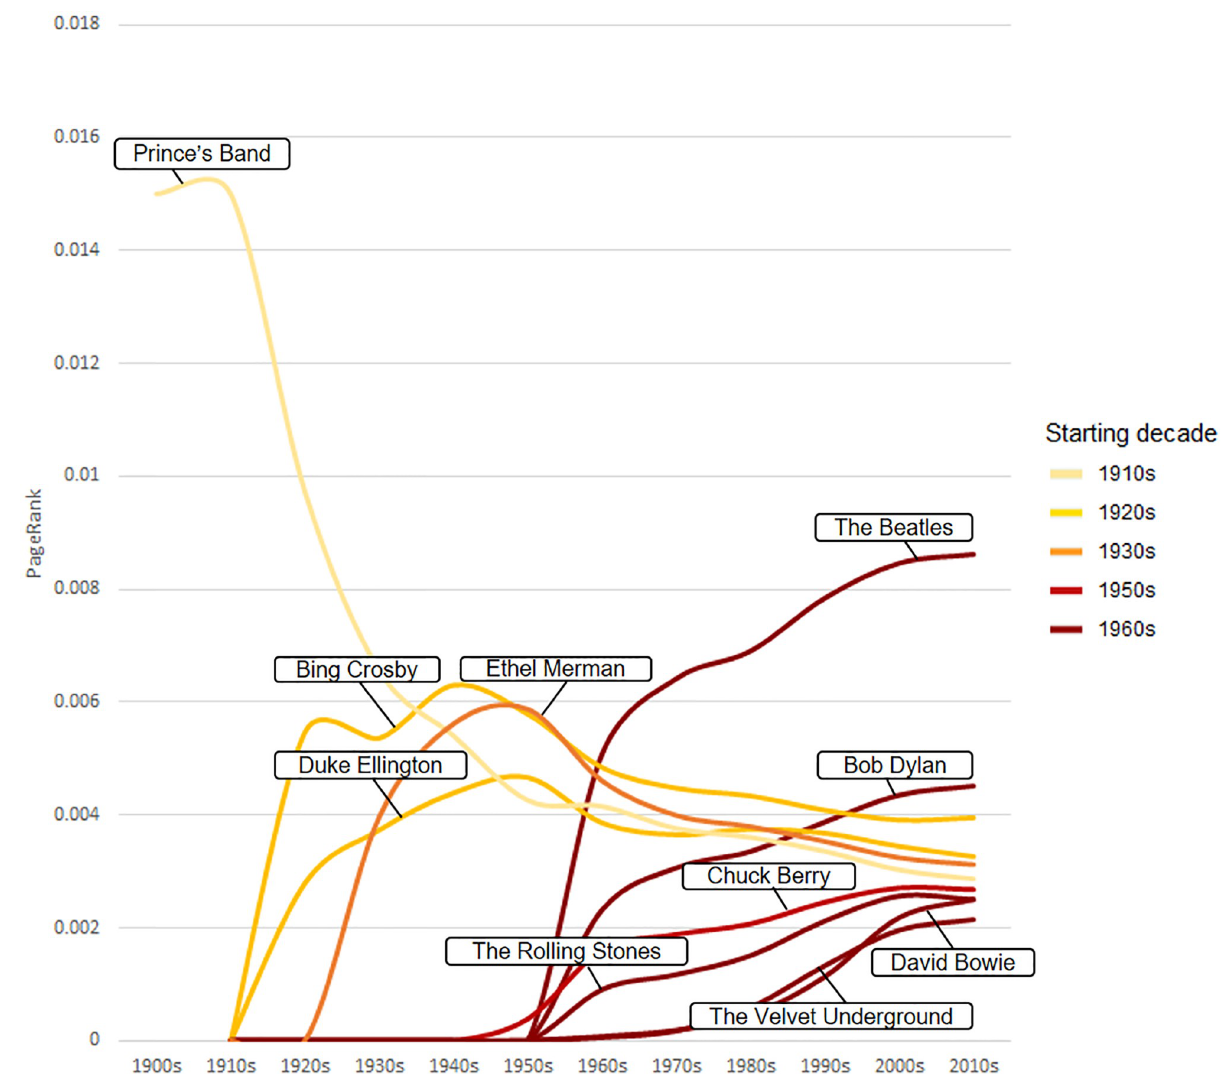
Fig 5. Evolution of the PageRank of the first ten artists in each